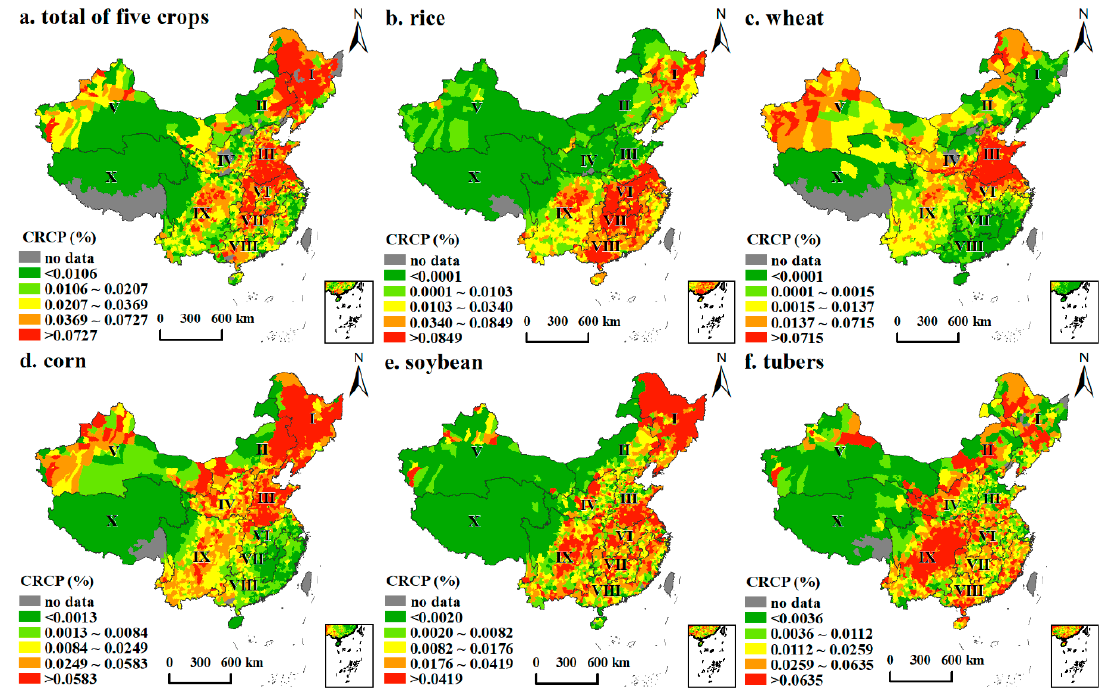
Figure 2. Spatial distribution of crop production in 2015 (CRCP represents the concentration ratio of crop production).